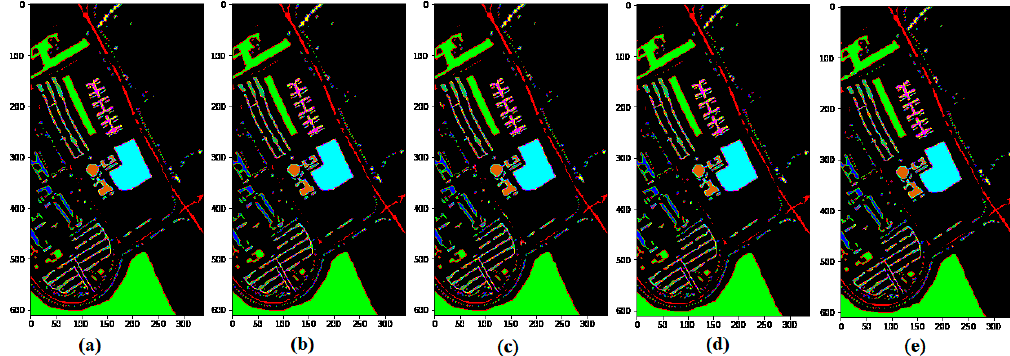
Figure 10. Classification maps of the University of Pavia (UP) dataset: ( a ) Ground truth; ( b ) M3D-CNN; ( c ) SSRN; ( d ) HybridSN; ( e ) GGBN.